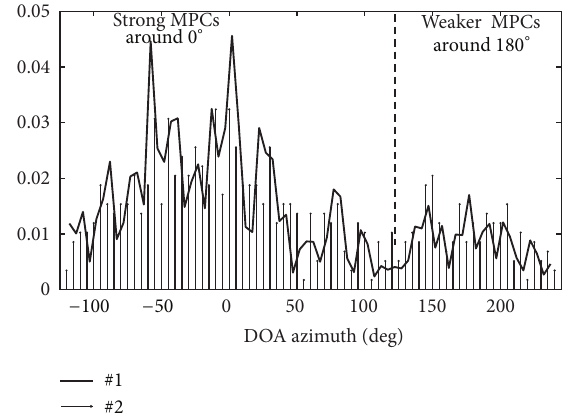
Figure 6: Number 1 is the power of MPCs that arrive at the certain azimuth in –120 ∘ to 240 ∘ , where the total power in the range is 1; number 2 is the probability of MPCs that arrive from the related azimuth, where the total probability in the range is